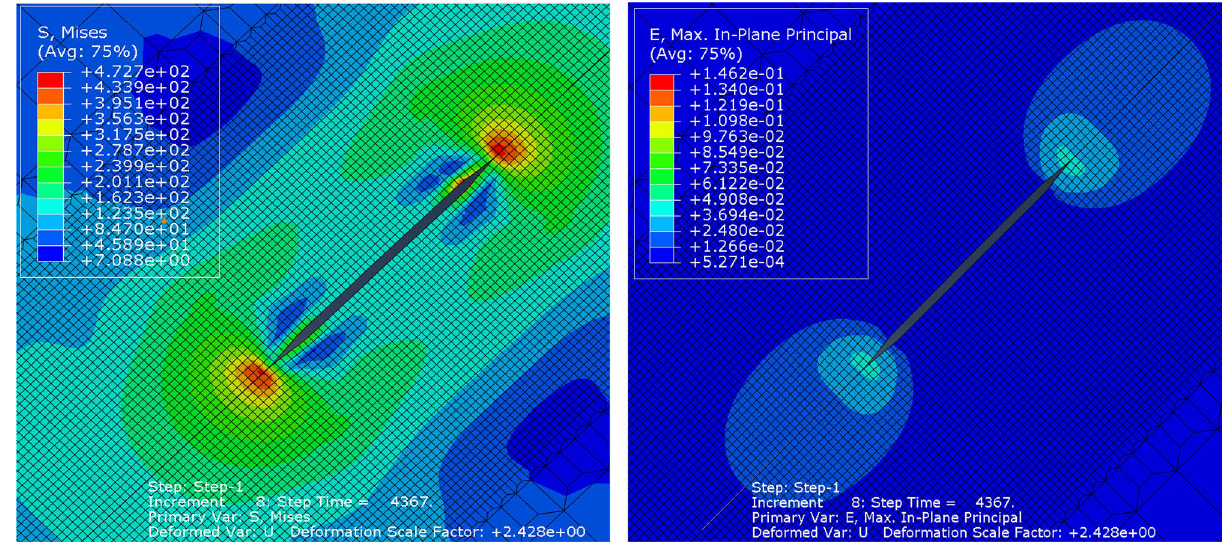
Fig. 20 Stress and strain nephograms of the inclined-crack